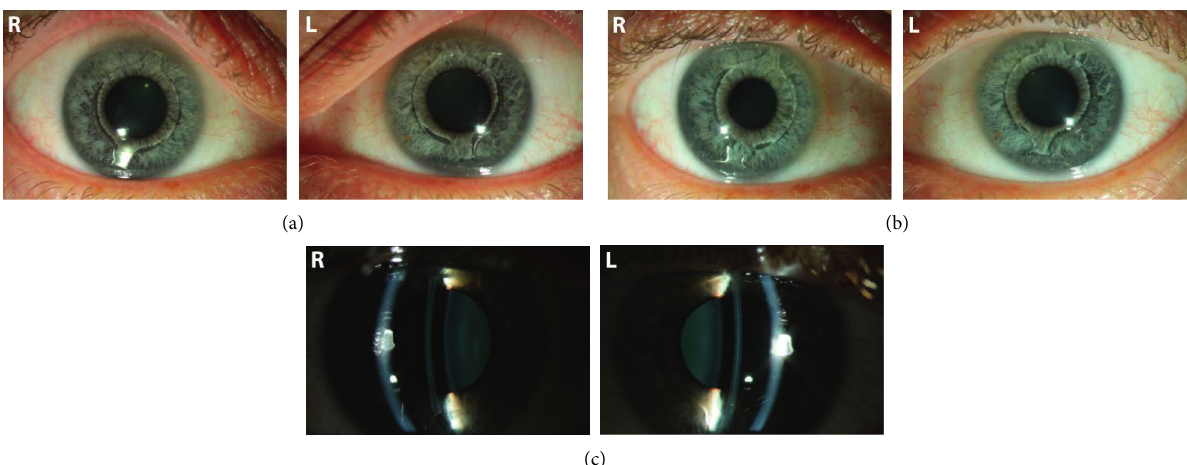
Figure 1: Slit lamp images of the AcrySof Cachet angle-supported pIOL in the anterior chamber postoperatively. (a) 1 year, right (left image column) and left (right image column) eye. (b) Five years postoperatively, in the same patient. Note the slight rotation of the IOL especially in the left eye (right image column). (c) Vertical slit lamp image for control and exclusion of any contact between the pIOL, the cornea, or the crystalline